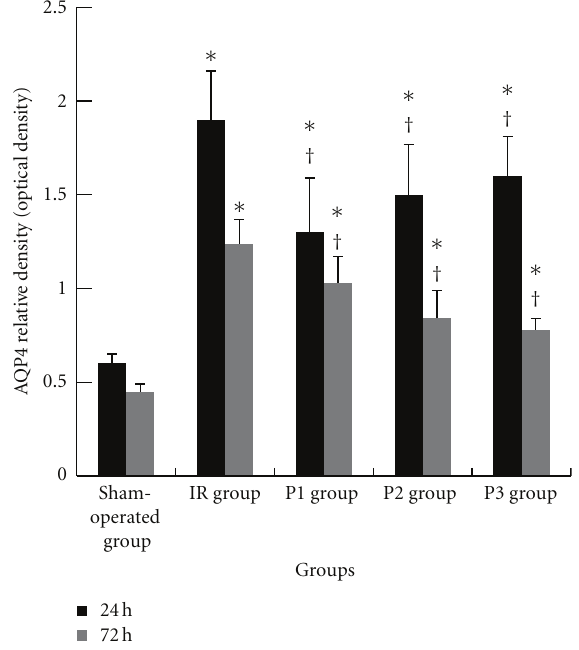
Figure 7: AQP4 relative density of five groups. ∗ P < 0 . 01, versus sham-operated group; † P < 0 . 05, versus IR group. There were significant di ff erences in P1, P2, P3 groups than that in IR group. But there was no obvious di ff erences between P1, P2, and P3 groups in AQP4 relative